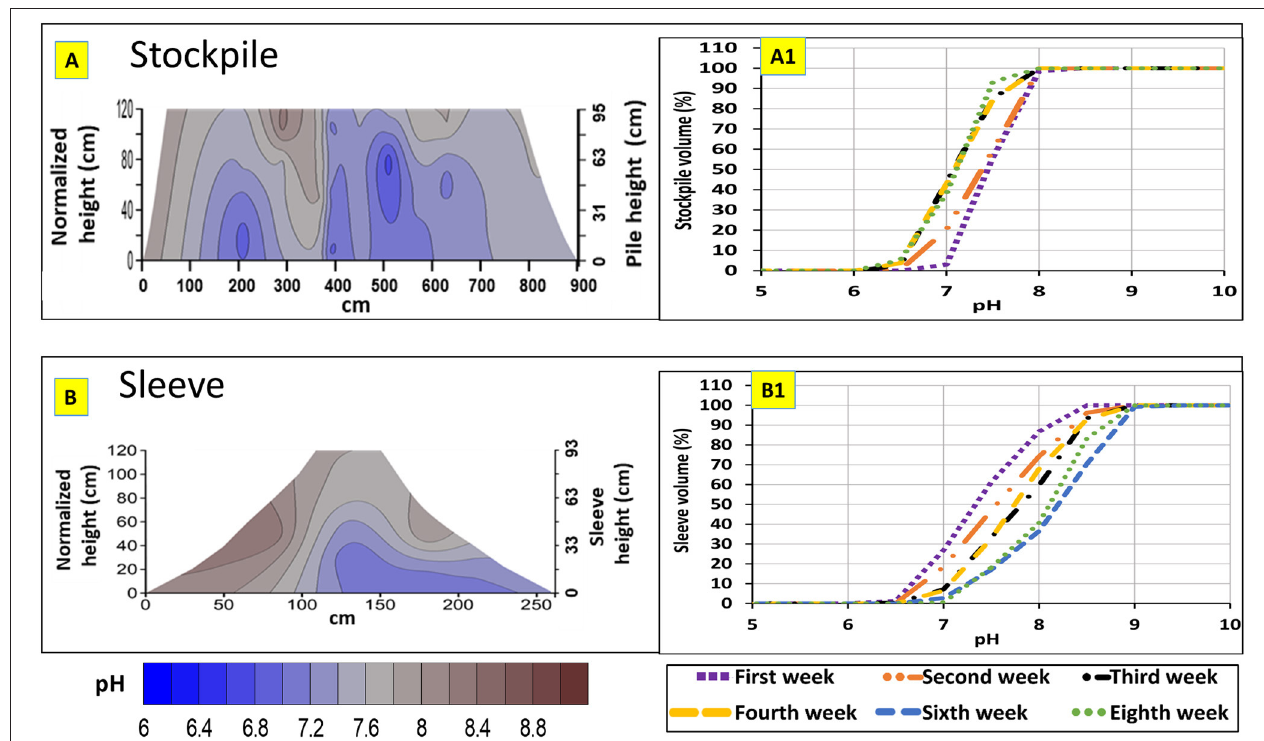
FIGURE 4 | Spatial–temporal variation of pH. Contour maps (week 1) and the cumulative volumetric percentage of pH in the stockpile (A,A1) and the sleeve ( B ; cross-section II, B1 ; weighted average of cross-sections